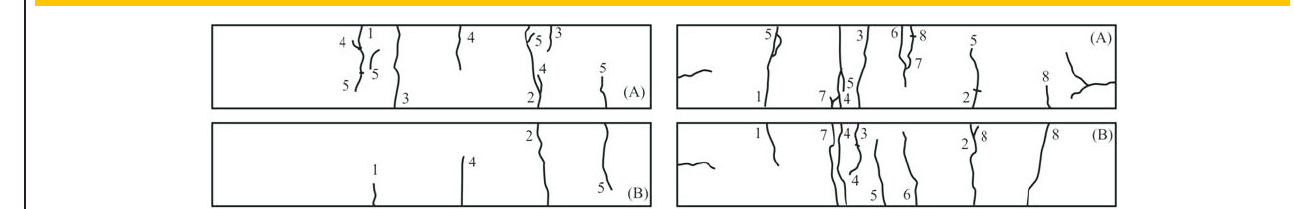
Figure 15 – Final crack patterns in four faces of tension specimens made of concrete with mineral additions reinforced with 1.00% of